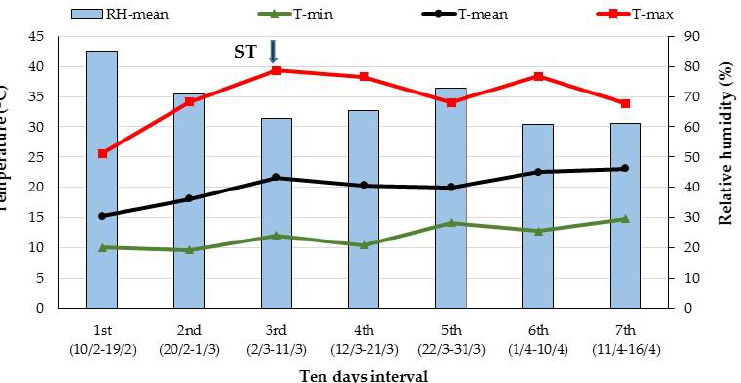
Figure 1. The growing conditions, mean relative humidity (%) and temperatures (minimum, maxi- mum and mean temperature; °C) throughout the experimental period. The left vertical axis pre- sents the temperature mean values and the right vertical axis presents the relative humidity mean values; ST: start of treatments’ application.